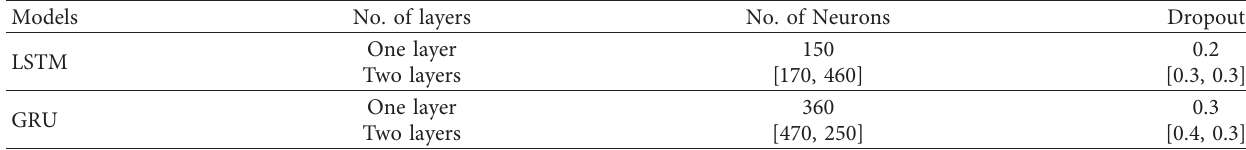
Table 10: The best value parameters of DL for confirmed cases in Kuwait.